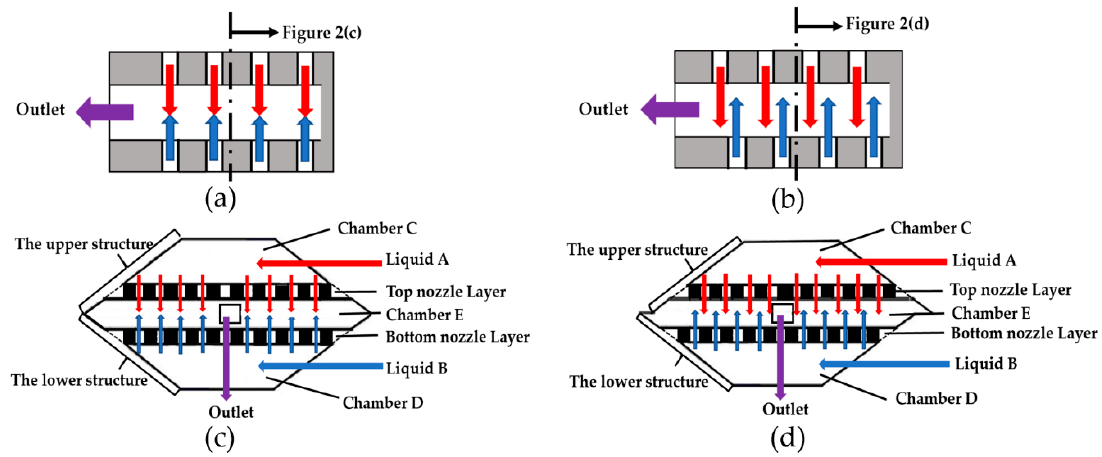
Figure 2. Design options of the jet-impinge mixer: ( a ) Opposite micronozzles directly facing each other; ( b ) Opposite side micronozzles, off-set; ( c ) Cross-section on the top plane of design ( a ); ( d ) Cross-section on the top plane of design ( b ).